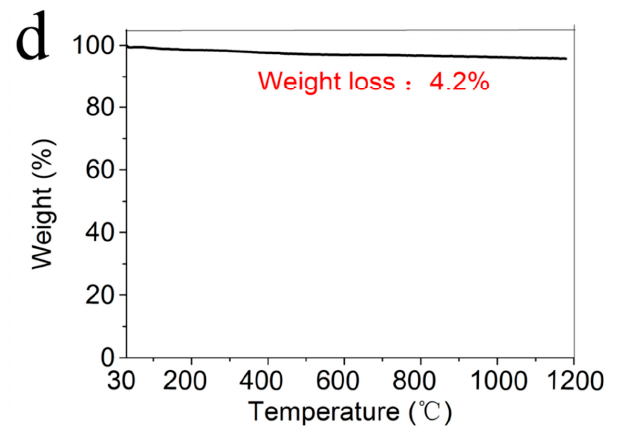
Figure 1. ( a ) A digital image of the fire-resistant paper pulp composed of ultralong HAP nan- owires, micrometer-sized glass fibers, and nanometer-sized inorganic adhesive; ( b ) A SEM